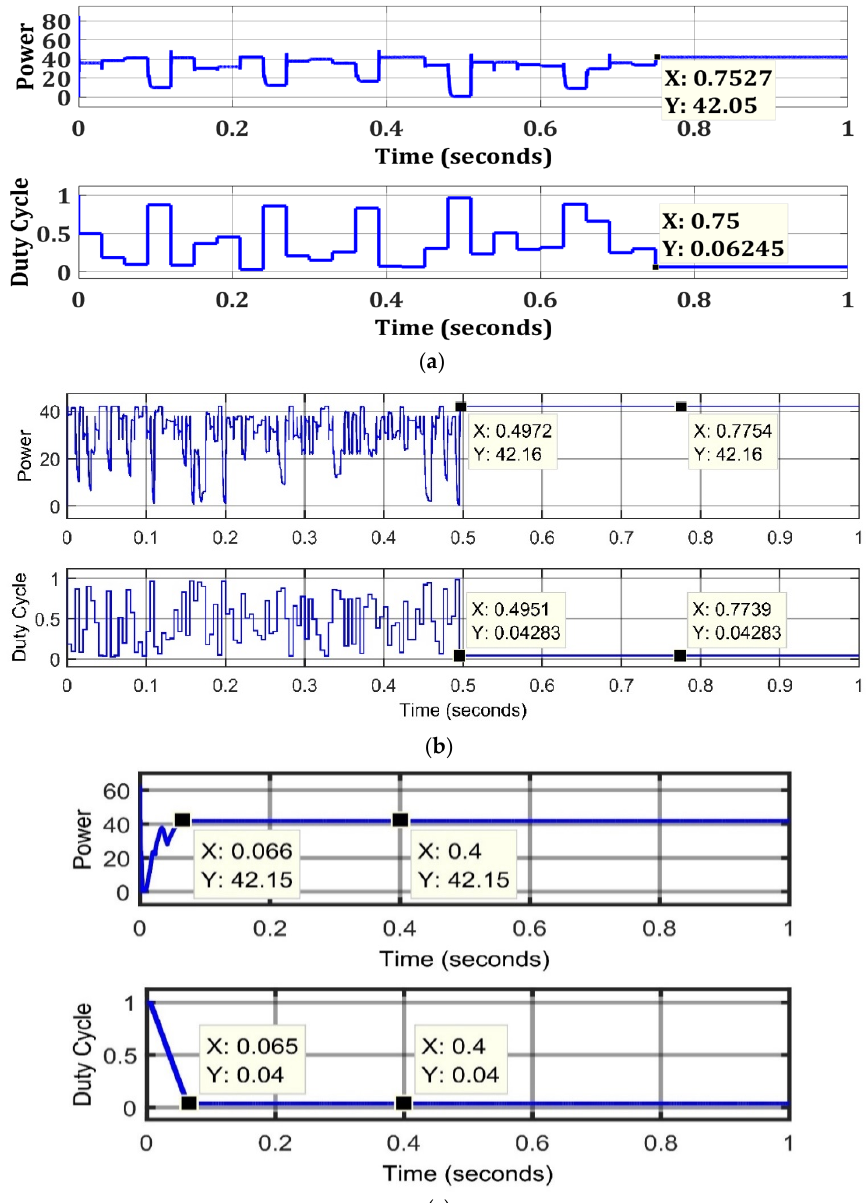
Figure 9. The characteristic curve of a 4S PV array under strong partial shading.